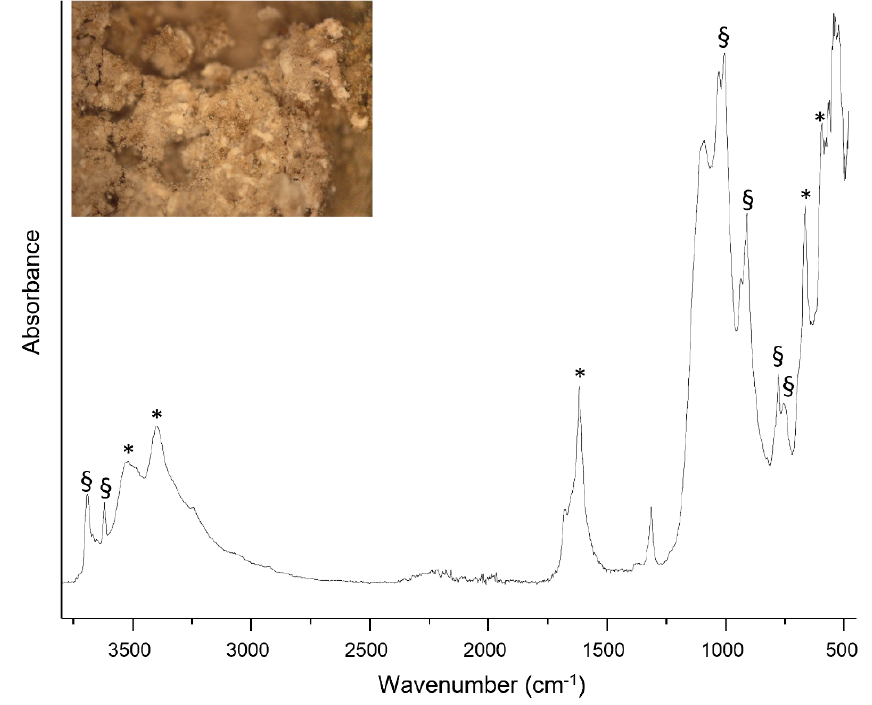
Figure 5. ATR-FT-IR spectrum of the preparation layer of a mural painting sample, recorded with 16 scans at 4 cm − 1 spectral resolution. The bands associated with the presence of kaolinite (750, 784, 915, 1007, 1029, 3616, and 3686 cm − 1 ) are highlighted with the asterisk (*), while those due to gypsum (595, 664, 1618, 3398, and 3529 cm − 1 ) are labeled with the symbol (§). The optical microscope image of the sample is depicted on the top.